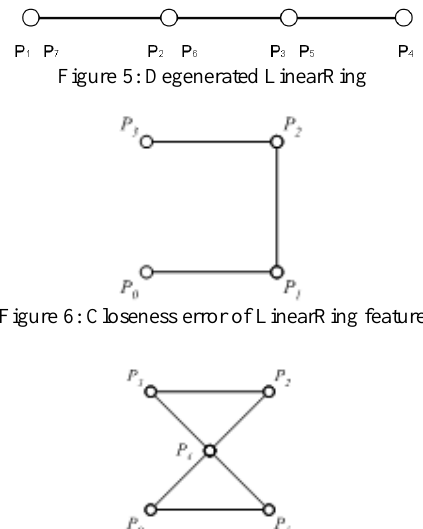
Figure 7: Self Intersection and Duplicate Point